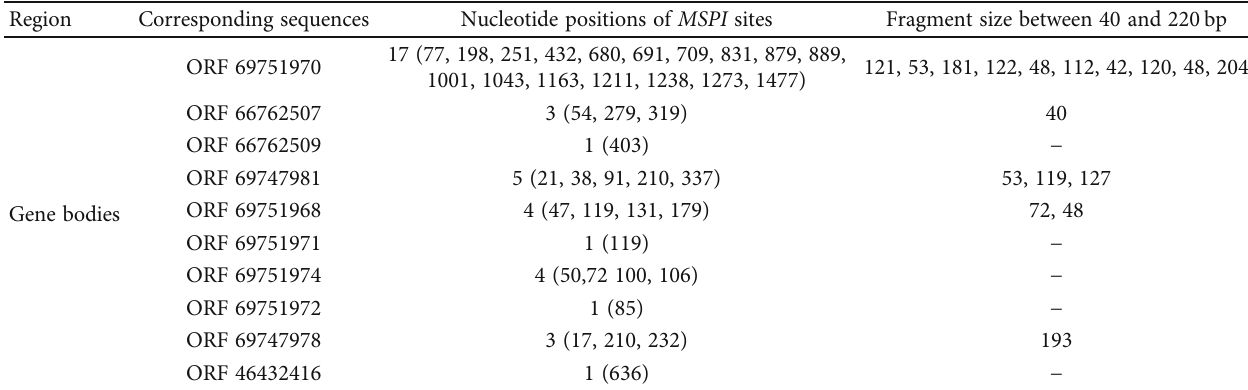
Table 8: MspI cutting sites and fragment sizes in gene body